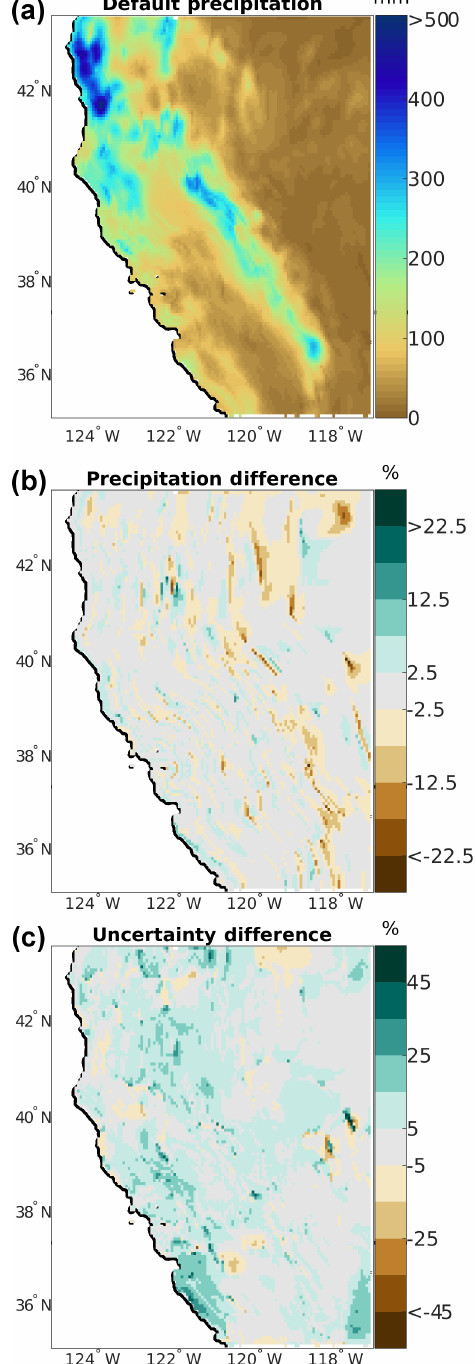
Figure 9. Spatial distribution of minimum temperature ( T min , ◦ C) for model parameter sensitivity experiment 1. (a) Default model pa- rameters, (b) modified distance weighting exponent, and (c) the dif- ference field (default – modified).